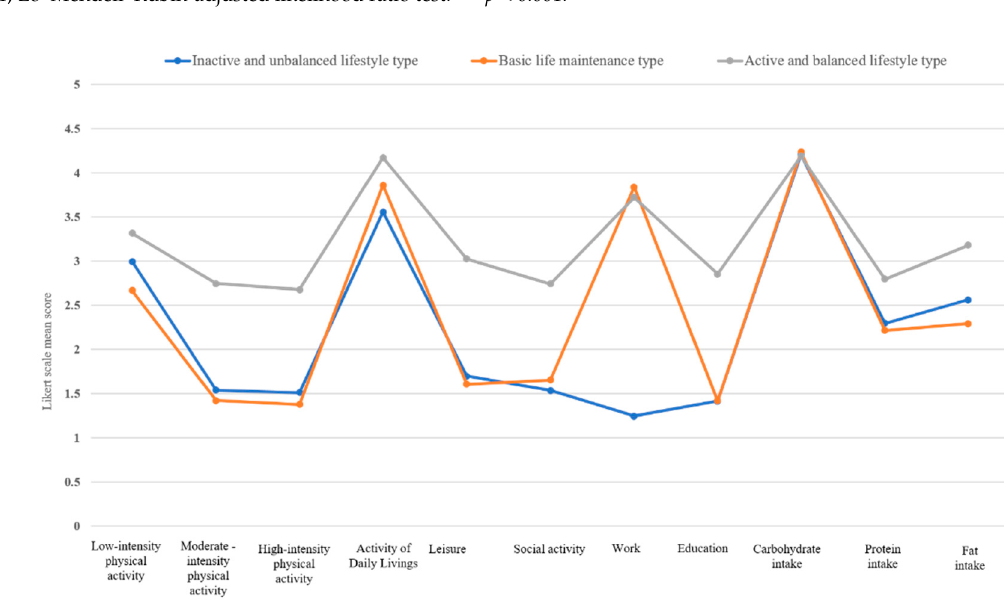
Figure 1. Three lifestyle profiles by 11 lifestyle factors.